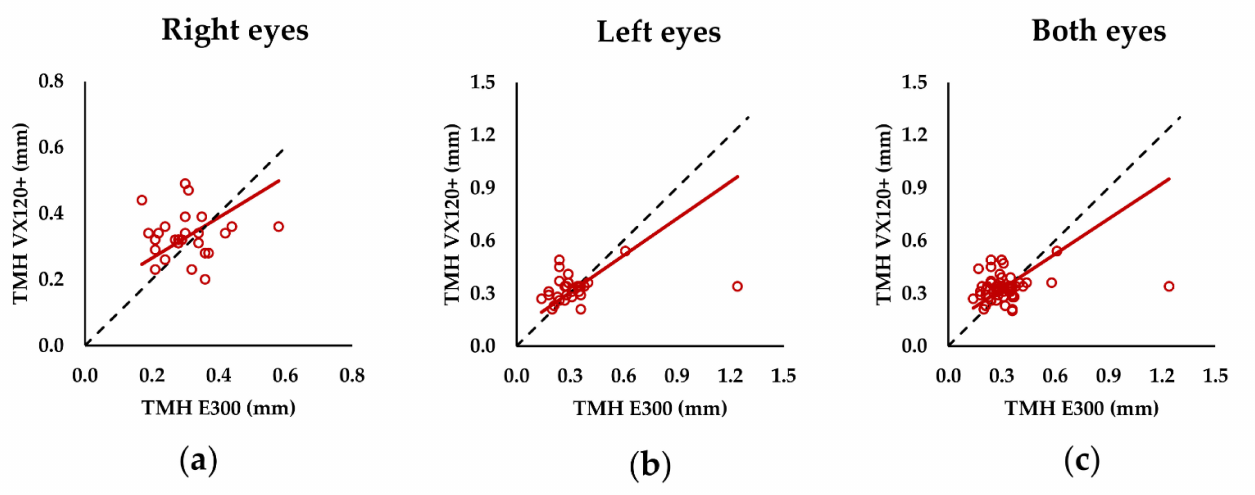
Figure 3. Passing–Bablok regression analysis for the agreement of the tear meniscus height (TMH) obtained from Medmont E300 and Visionix VX120+ devices comparing: ( a ) right eyes, ( b ) left eyes, and ( c ) both